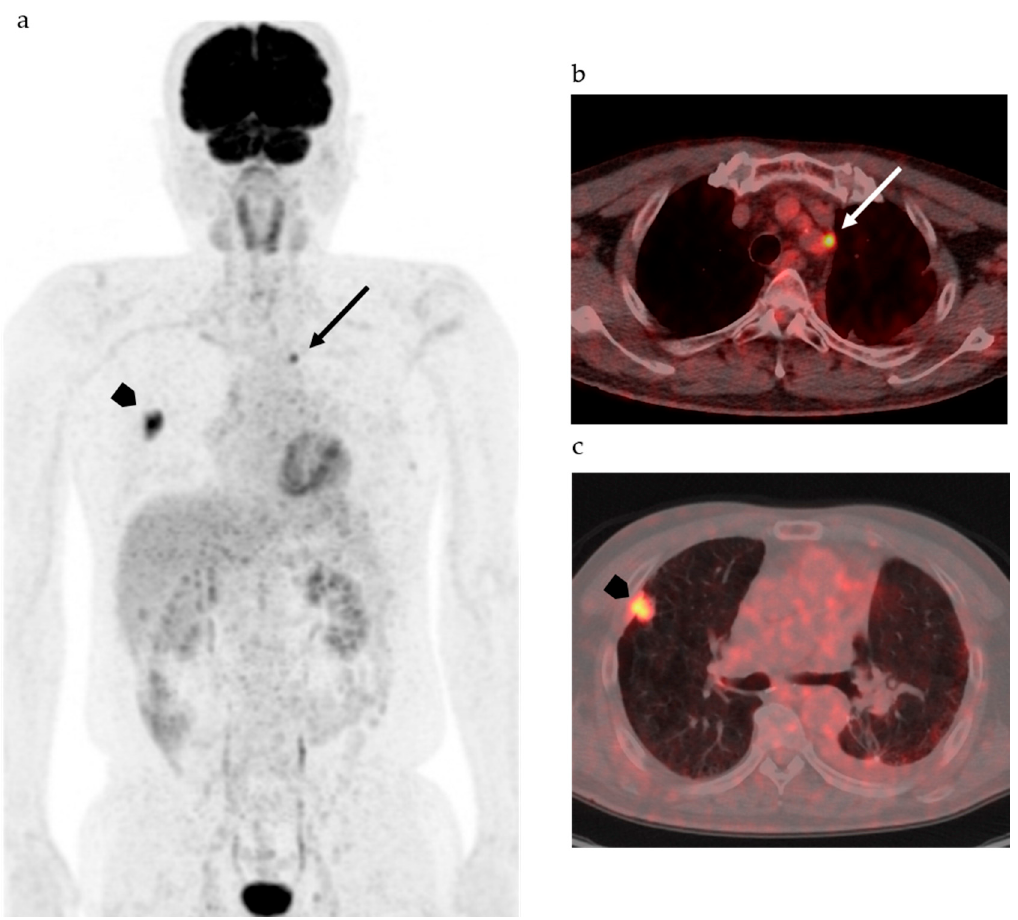
Figure 1. 2-[ 18 F] fluoro-2-deoxy- d -glucose positron emission tomography / computed tomography (FDG-PET / CT) of patients with non-small cell lung cancer. ( a ) Maximum intense projection image shows abnormal FDG uptake in the left upper mediastinum (arrow) and the right lung (arrowhead). ( b ) PET/CT shows increased FDG uptake in the lymph node adjacent to the left subclavian artery at the level of the upper mediastinum (arrow). ( c ) High FDG uptake is seen in the nodule at the right upper lobe (arrow head).